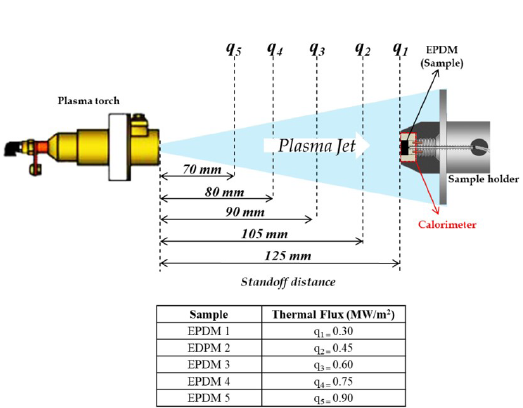
Figure 2. Schematic drawing of the ablation system and the distances with thermal flows.